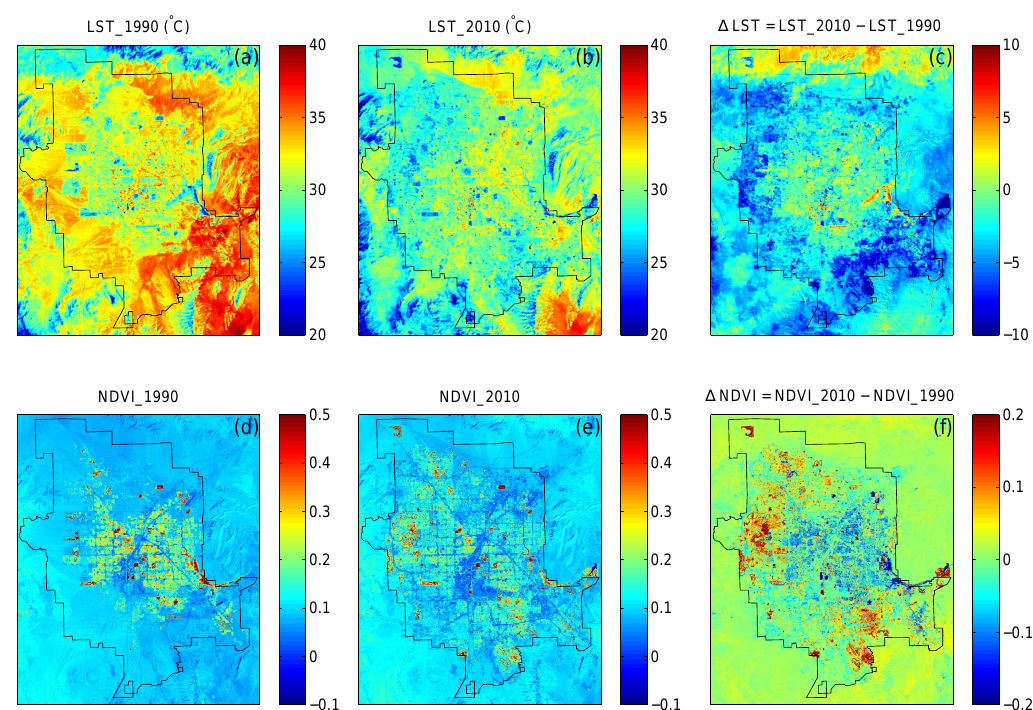
Figure 11. Comparison of annual averages of LST ( a , b ) and NDVI ( d , e ) during 1990 and 2010. The differences are shown in ( c ) for LST and ( f ) for